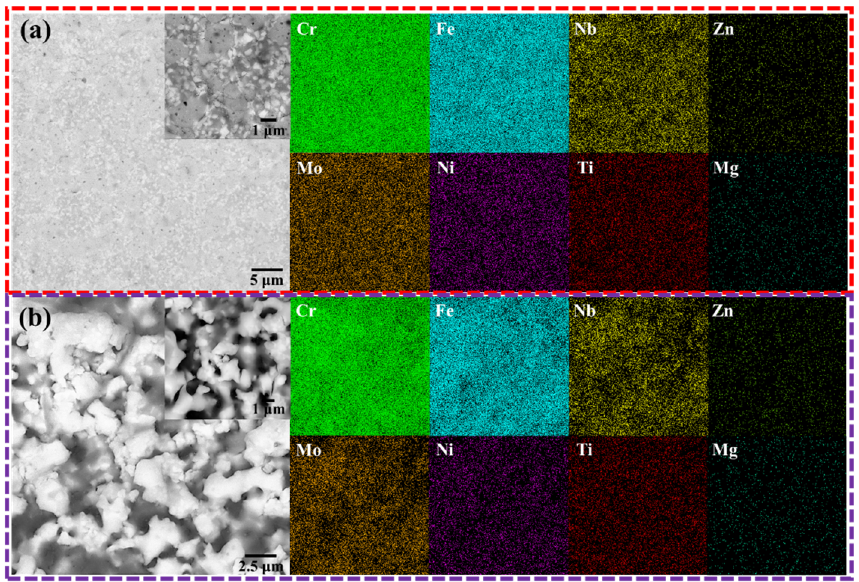
Figure 14. SEM images and EDS mapping of the alloy residue after vacuum distillation: ( a ) smooth surface; ( b ) fracture surface.